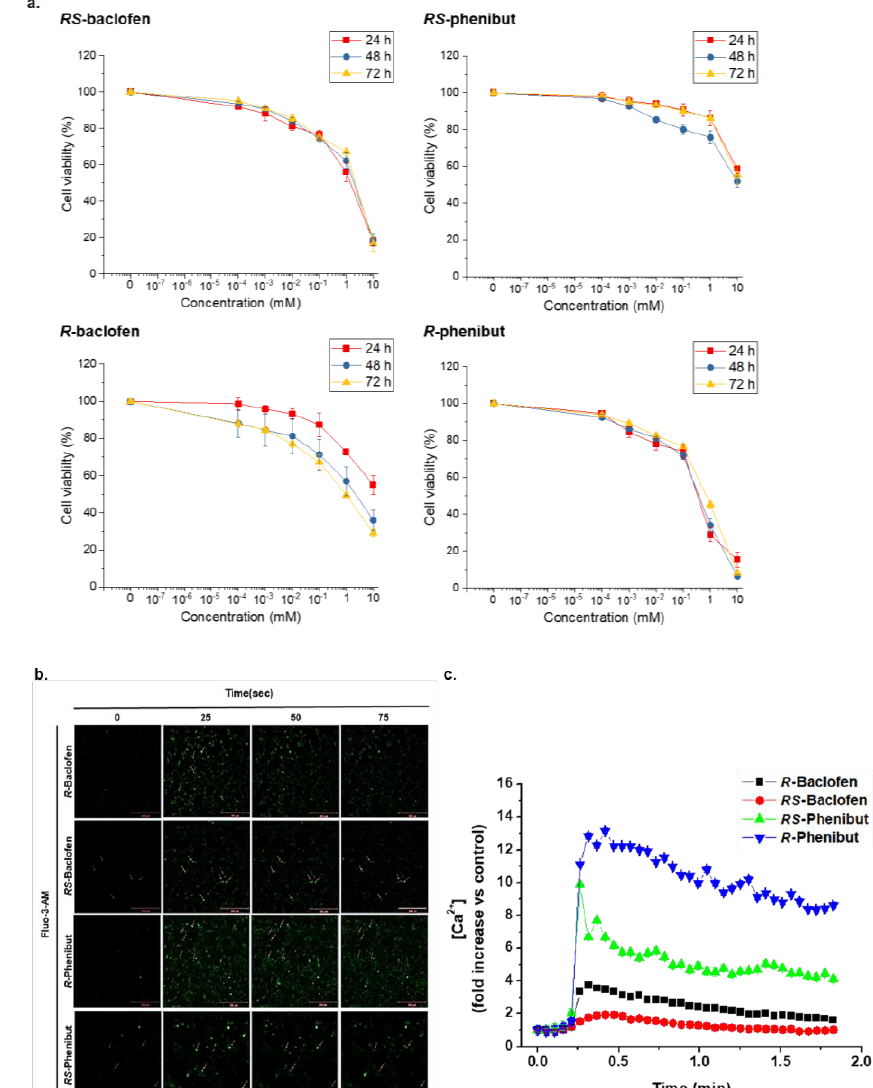
Figure 7. In vitro cell viability test and comparison of Ca 2+ release in response to RS -baclofen, RS - phenibut, and R -phenibut with R -baclofen. ( a ) Cell viability analysis of the compounds against HEK293T cells. The cells were treated with R -baclofen, RS -baclofen, RS -phenibut, and R -phenibut for 24, 48, and 72 h. The cell viability (%) was calculated as per the CCK-8 assay protocol. Each value represents the mean ± SEM of three independent experiments. ( b ) Representative Fluo-3-AM fluorescence images of the intracellular Ca 2+ level in HEK293T cells treated with RS -baclofen, R - baclofen, RS -phenibut, and R -phenibut (1 µ M, final concentration). R -baclofen was used as a positive control. Scale bar: 200 µ m. ( c ) The intensity of Ca 2+ release over time after treatment with RS -baclofen, R -baclofen, RS -phenibut, and R